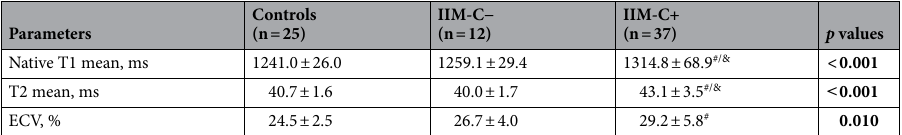
Table 3. CMR tissue characteristic parameters of controls, IIM patients without and with myocardial involvement. Data are expressed mean ± standard deviation, or median (interquartile range). Bold value denotes P < 0.05 for ANOVA or Kruskal–Wallis test. IIM, idiopathic inflammatory myopathy; CMR, cardiac magnetic resonance; ECV, extracellular volume. # Indicates adjusted P < 0.05 for controls versus IIM-C+. § Indicates adjusted P < 0.05 for controls versus IIM-C−. & Indicates adjusted P < 0.05 for IIM-C- versus IIM-C+.